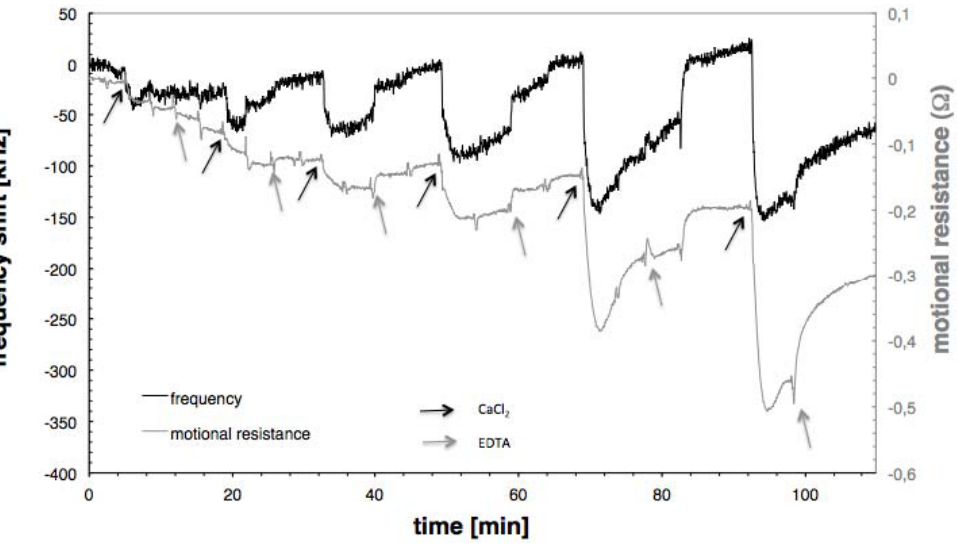
Figure 2. Frequency and motional resistance caused by the calcium adsorption in increasing concentrations. Black arrows show the injections of CaCl EDTA